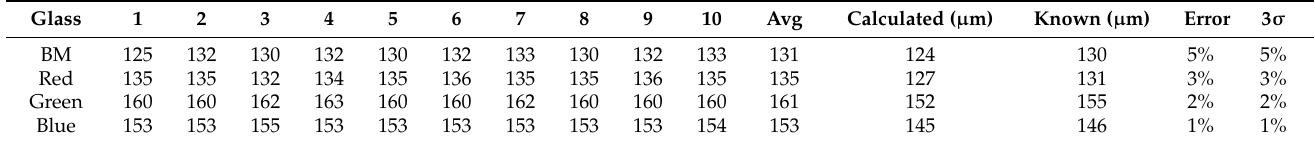
Figure 6. Images showing the grayscale with the threshold value for the black matrix (BM) as well as the red, green, and blue for the color filter (CF). Table 2. The height measurement as indicated ten times compared to the golden sample, including uncertainty